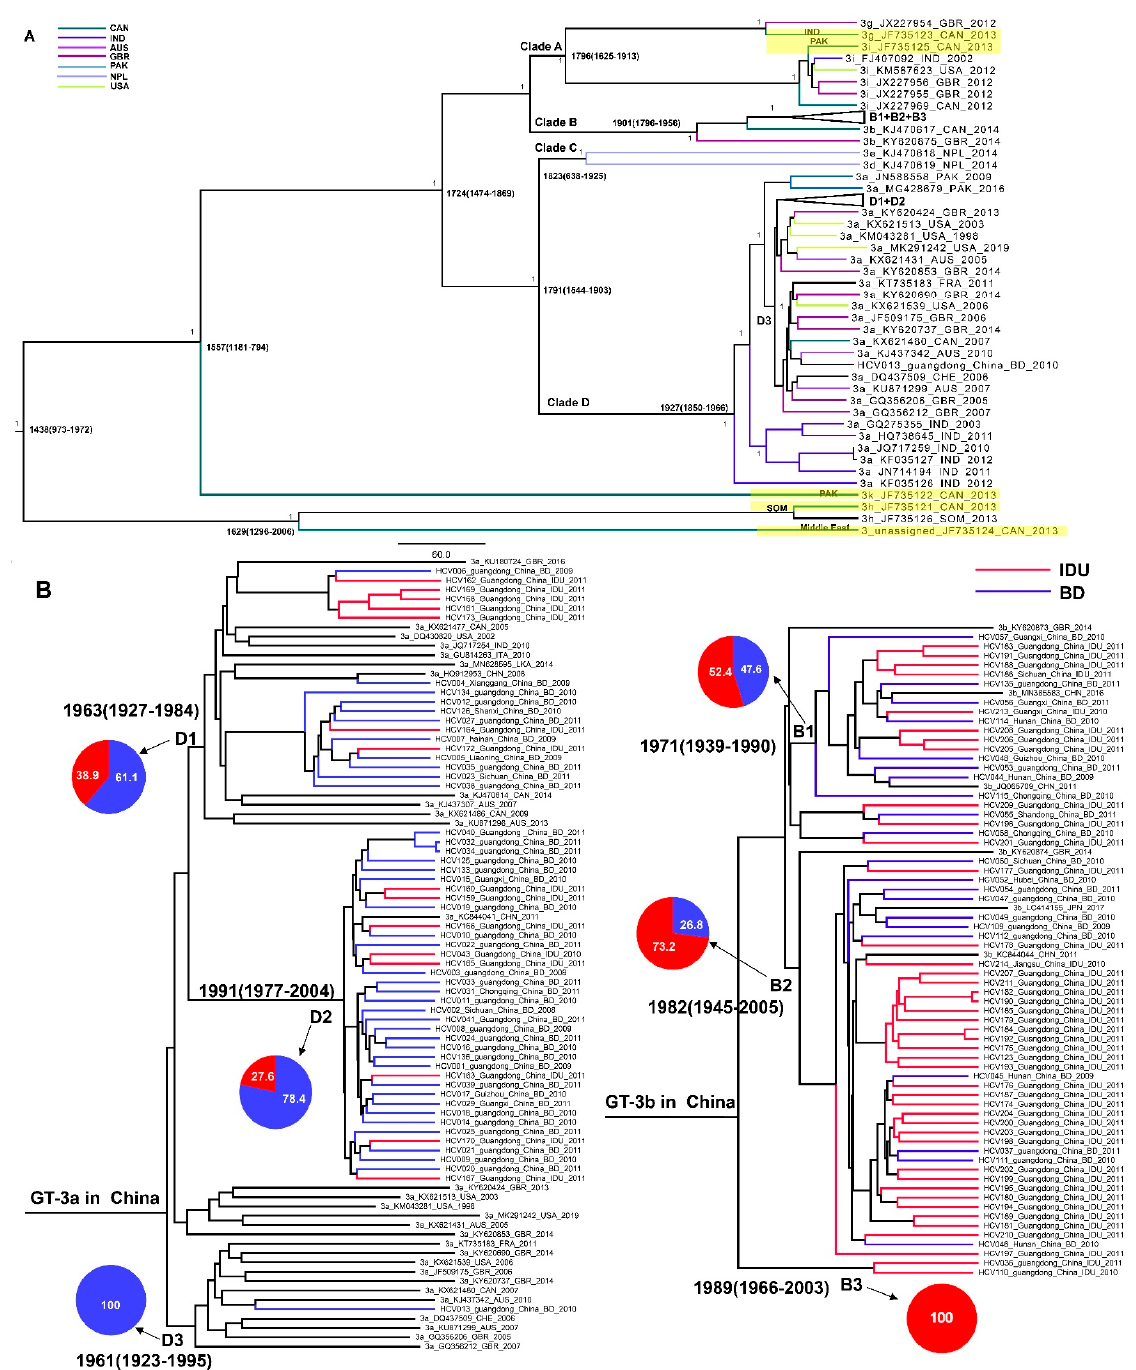
Figure 3. Bayesian phylogenetic tree based on full-length sequences of HCV GT-3 isolates. The posterior value and tMRCA are shown for the main clusters. References are named with the following format: Subtype_GenBank accession number_collection country_collection date. ( A ) Bayesian phylogenetic tree with collapse of GT-3a and GT-3b in China. The yellow highlights showed the origin of reference sequences. ( B ) The clade of GT-3a and GT-3b in China and the pie chart which shows the proportions of IDUs/BDs per each